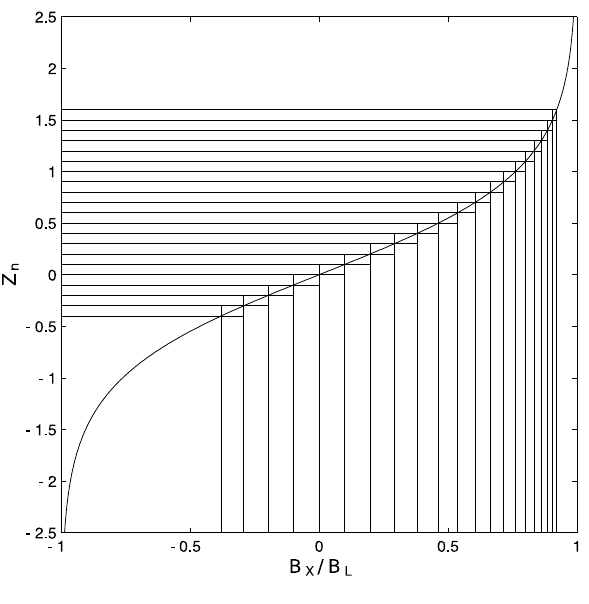
Fig. 2. A current sheet coverage is defined as a time interval where at least one magnetic field sample is obtained from each rectangle in the figure above in less than 5min. This figure is for current sheet coverages in the Northern Hemisphere.